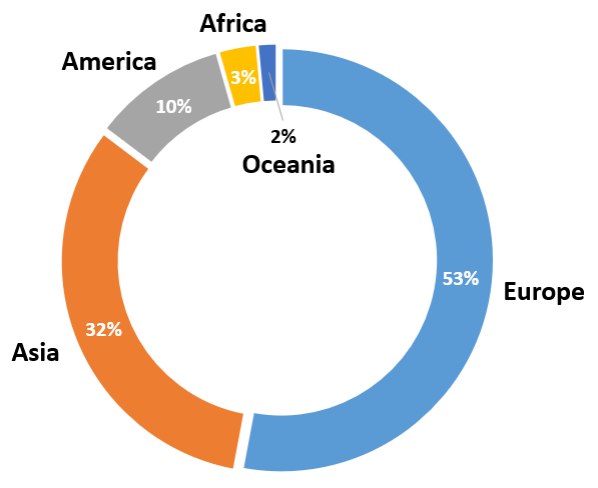
Figure 9. Location distribution for the published journal